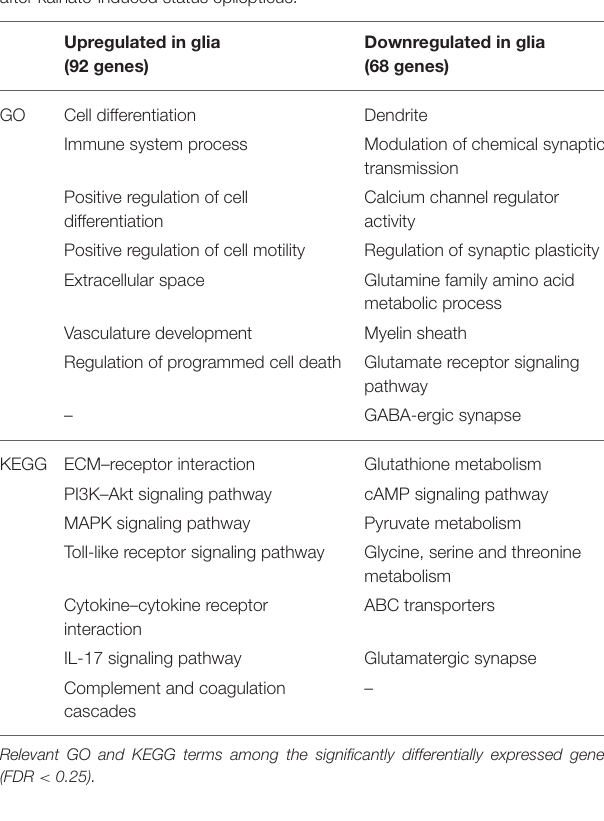
TABLE 8 | Selection of relevant Gene Ontology (GO) and Kyoto Encyclopedia of Genes and Genomes (KEGG) terms of the differentially expressed genes in glia in the ipsilateral hippocampus (but not in the contralateral hippocampus) at 24h after kainate-induced status